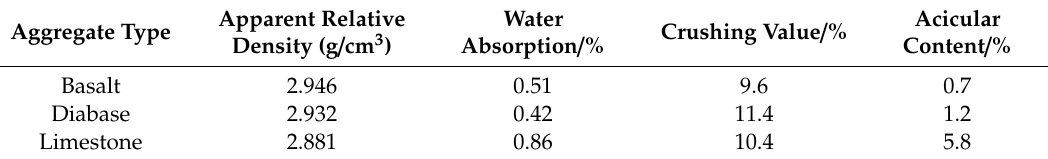
Table 1. Material properties of di ff erent